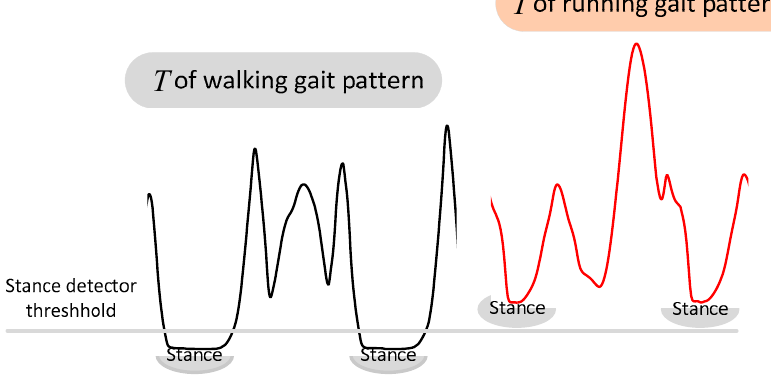
Figure 4. Comparison of T in a walking and running gait pattern.